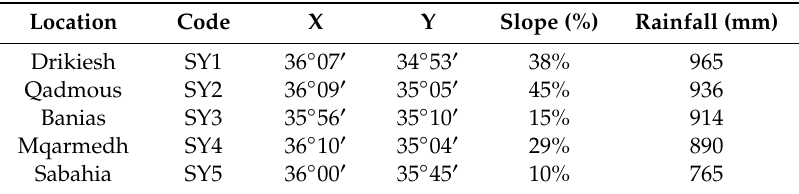
Table 1. Experimental characteristics of the five locations studied.